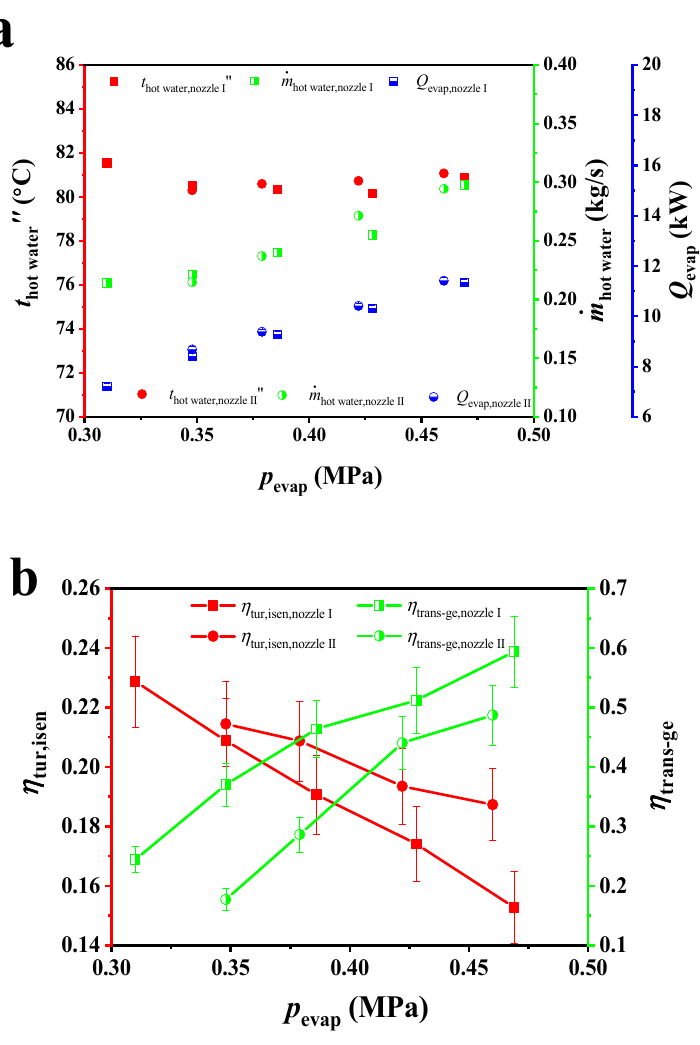
Figure 6. Variation of system performance with evaporating pressure (R123). ( a ): Parameters about the hot water; ( b ): Efficiency about the turbine and the generator.